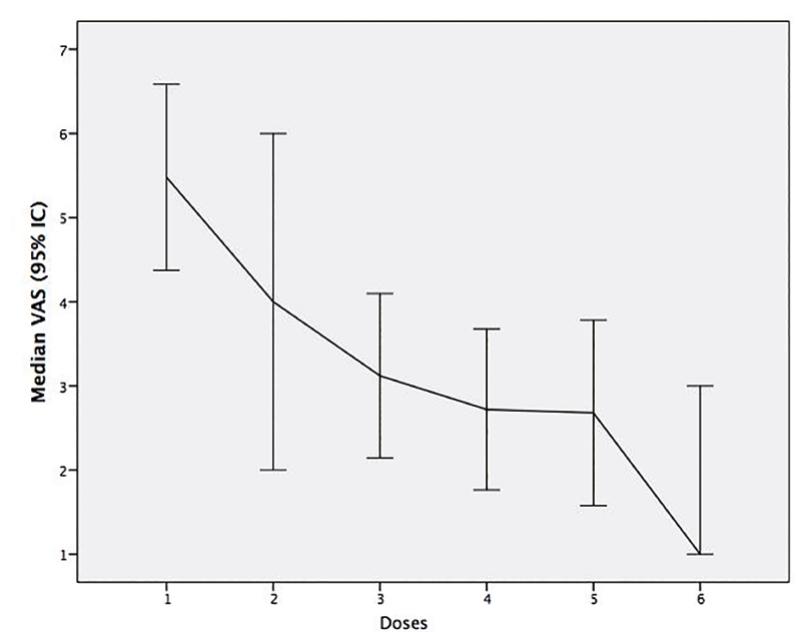
Figure 1 - Trend in VAS from the 1 st to the 6 th223 Ra cycles. There is a decrease in pain during complete therapy. The main pain improvement is visualized during the first three cycles of treatment.